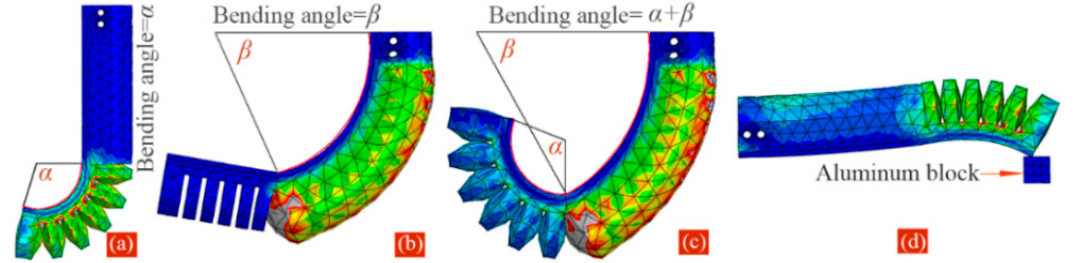
Figure 2. Definition of the bending angles: ( a ) module I, ( b ) module II, and ( c ) whole soft actuator. ( d ) The extraction of the output force of the actuator’s tip.